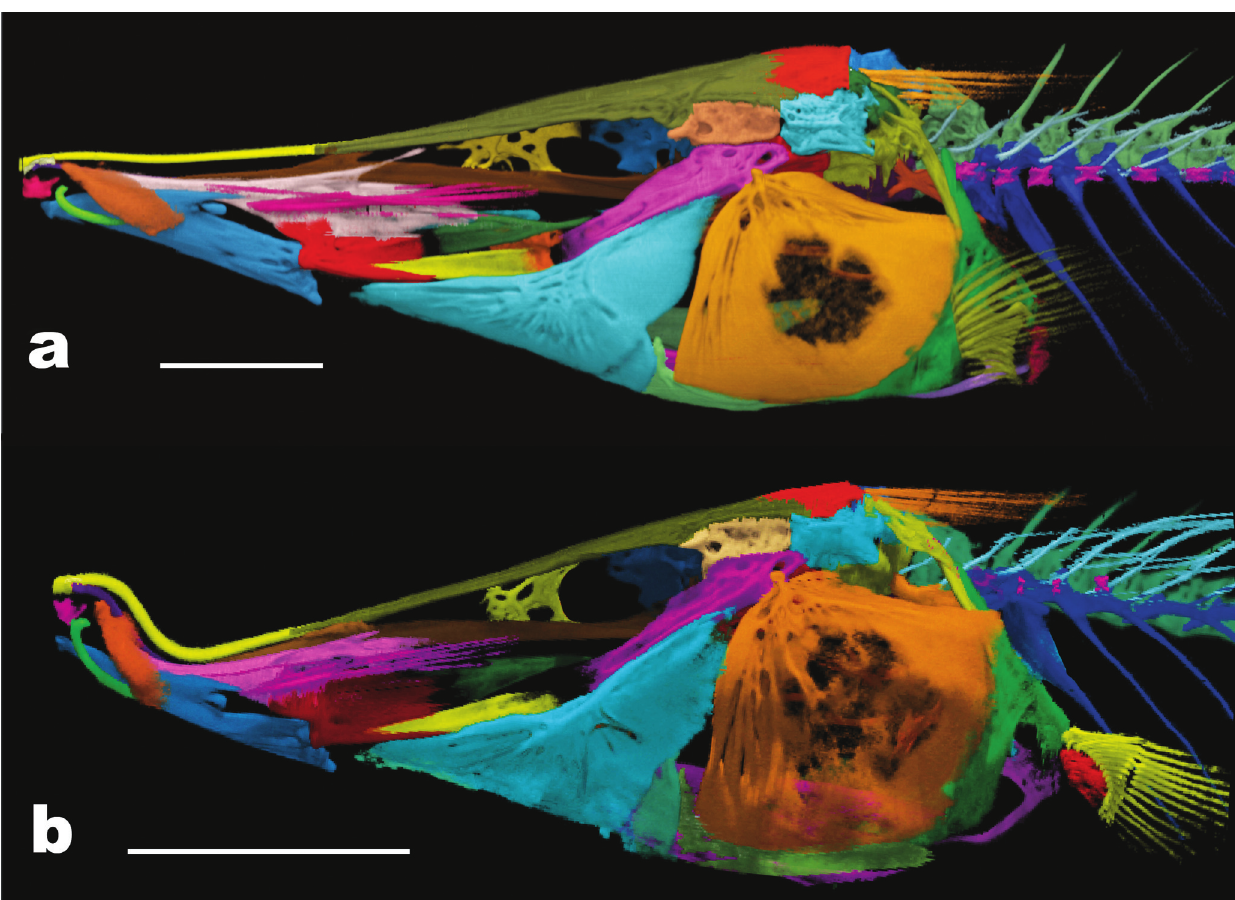
Fig. 3. Lateral view of the skull and cleithral region of Iracema caiana , ( a ) MZUSP 49205, 235 mm SL, scale bar is 5 mm; ( b ) MZUSP 49205, 345 mm SL, snout bent upwards due to preservation artifact. Scale bar is 10